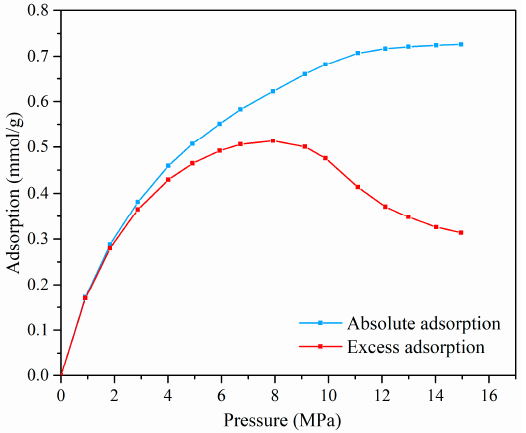
Figure 9. The absolute adsorption isotherm and the excess adsorption isotherm of CO 2 at 50 °C.